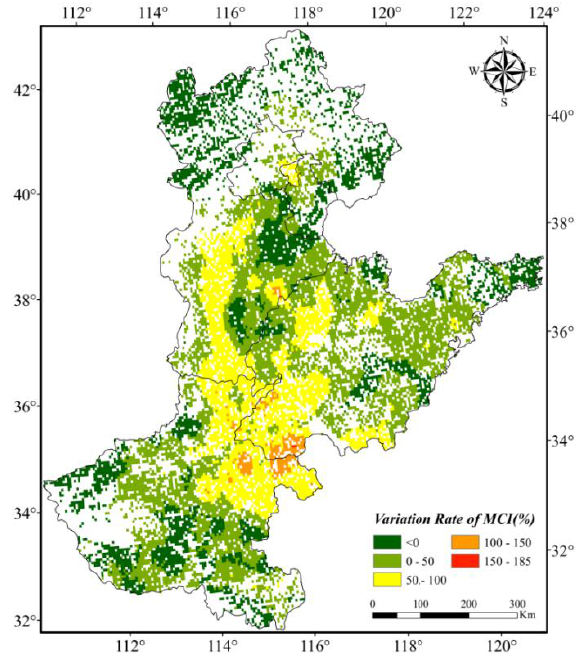
Figures 9 and 10 were created based on MCI change rates to reflect the spatial distribution of